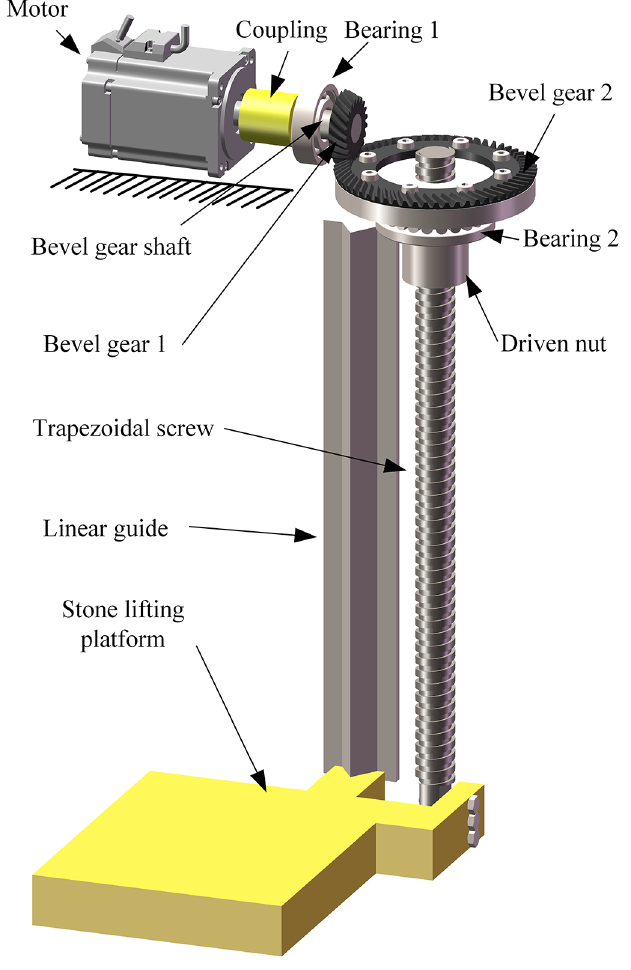
Fig. 2. Mechanical components of FDS.